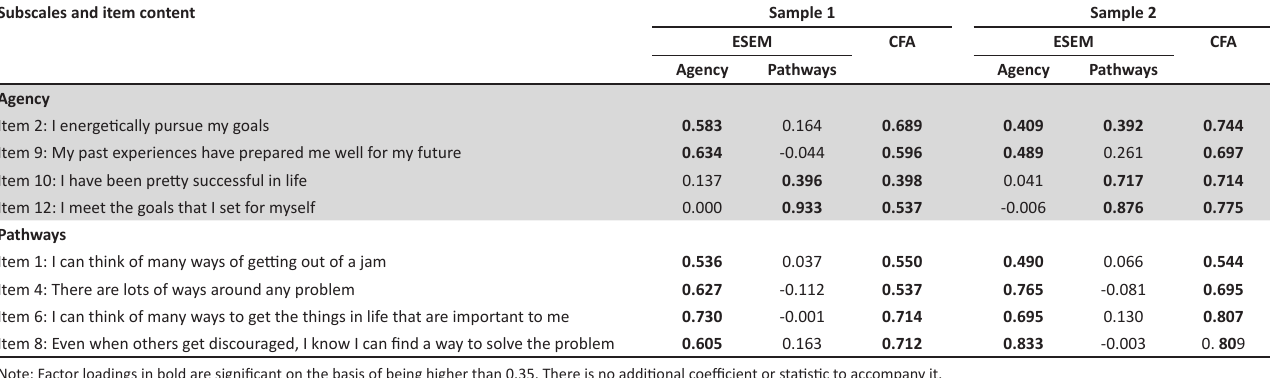
TABLE 3 : Standardised factor loadings of the two-factor models. Subscales and item